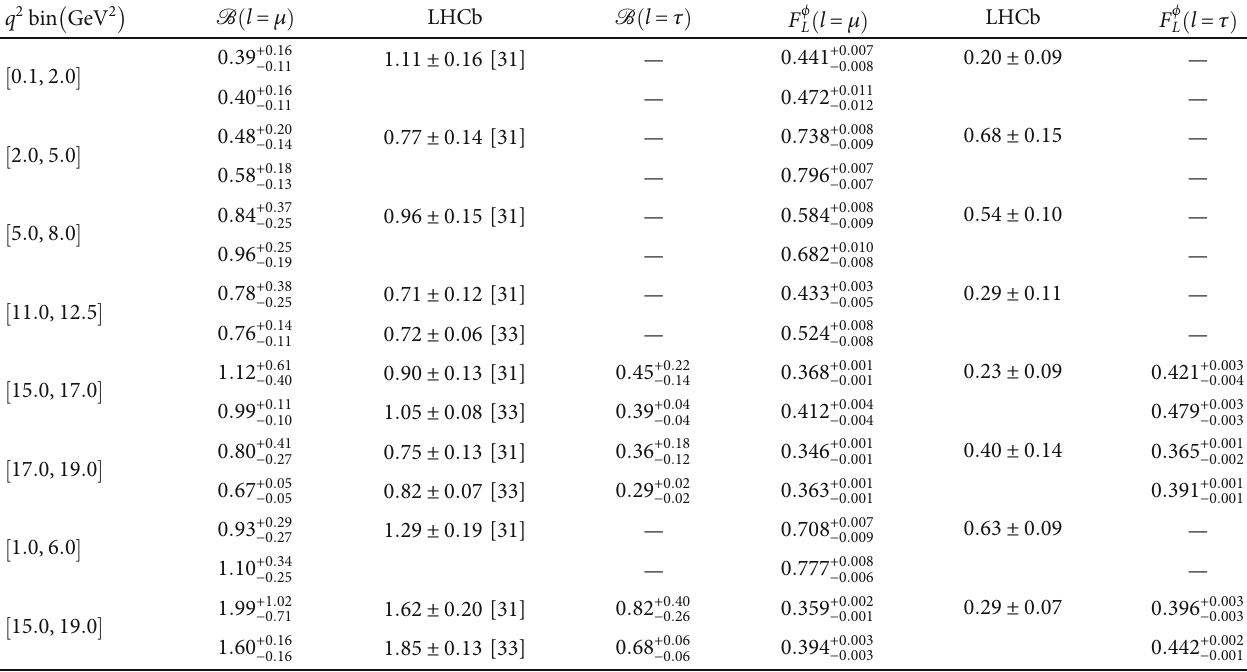
Table 9: Theoretical predictions for the q 2 -binned observables B ð B +Lattice ” (the second row) approach, respectively. For a comparison, we also list the new LHCb measurements [33].